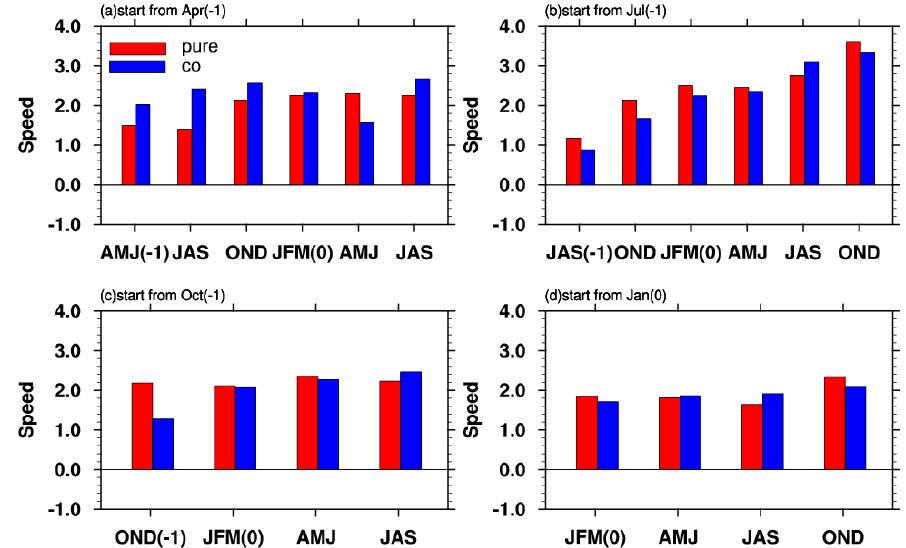
Figure 10. Histograms of the seasonal mean for wind strength produced by SPB-related initial errors for the pure IOD events and pIOD events that occurred with El Niño. Red bars represent the pure IOD events; blue bars represent the IOD predictions occurred with El Niño for ( a ) start month of April ( − 1), ( b ) start month of July ( − 1), ( c ) start month of October ( − 1) and ( d ) start month of January (0).